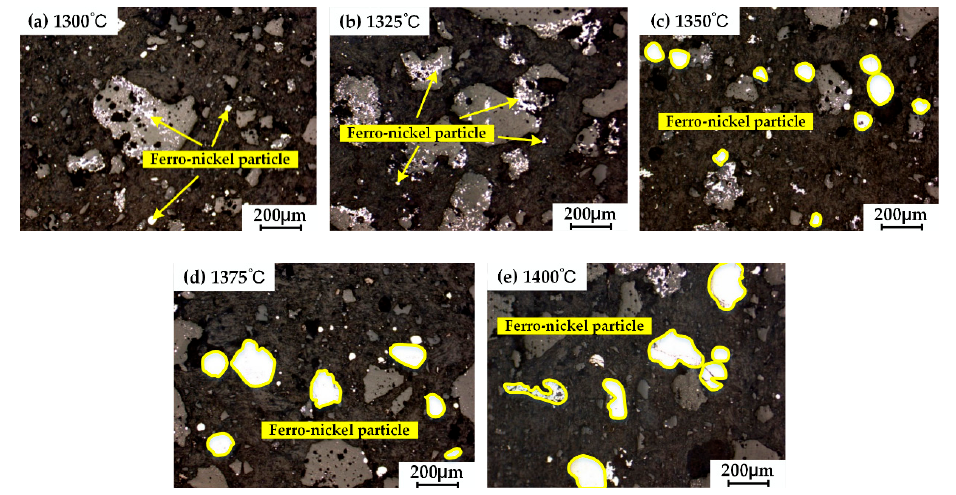
Figure 6. Optical microscope images of ferro-nickel particles under different reduction temperatures: ( a ) 1300 °C; ( b ) 1325 °C; ( c ) 1350 °C; ( d ) 1375 °C; ( e ) 1400 °C.